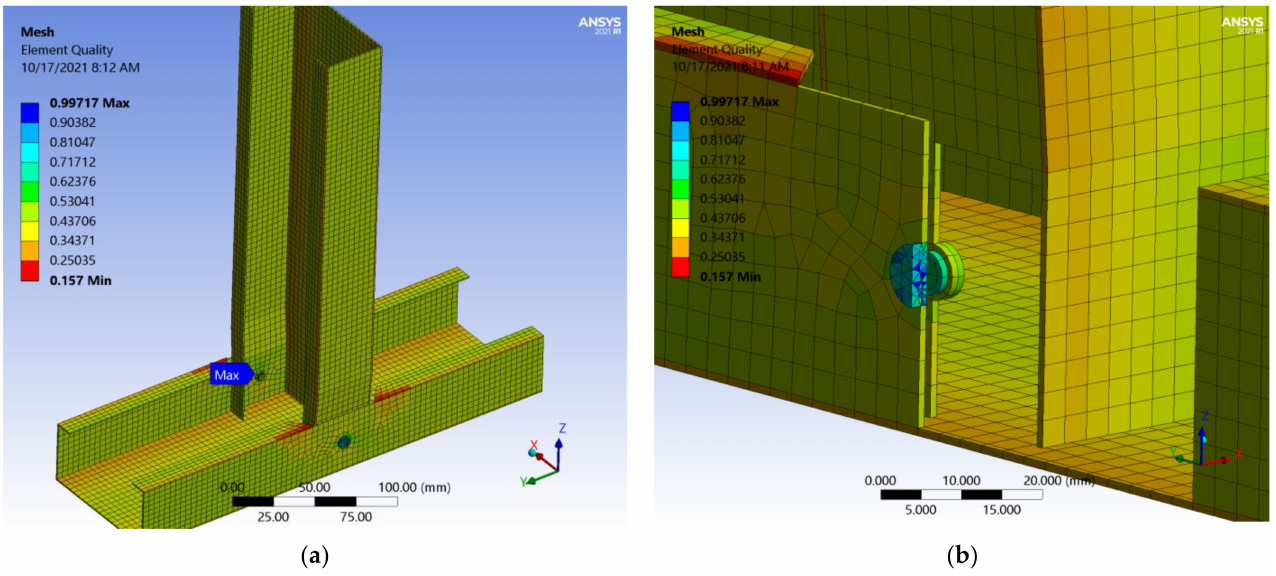
Figure 28. Mesh element quality joint B: ( a ) overall; ( b )